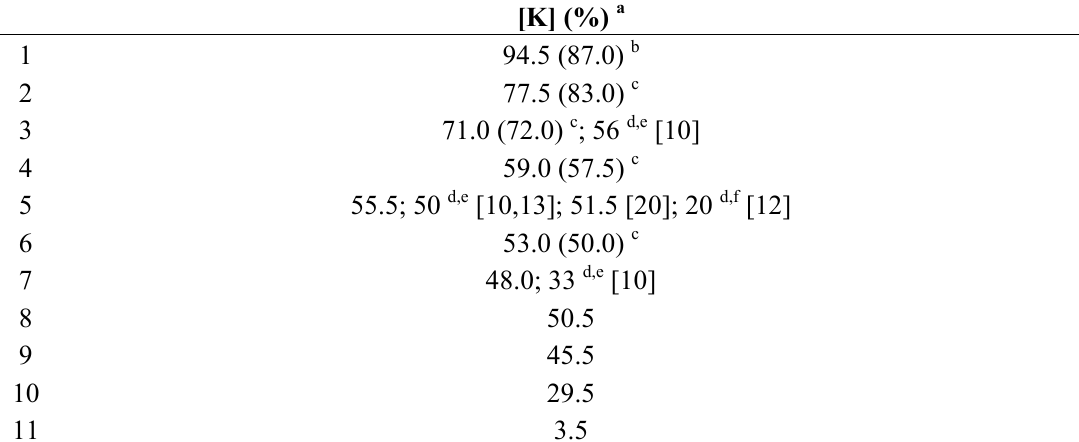
Table 5. Content of the K form (%) (in CDCl